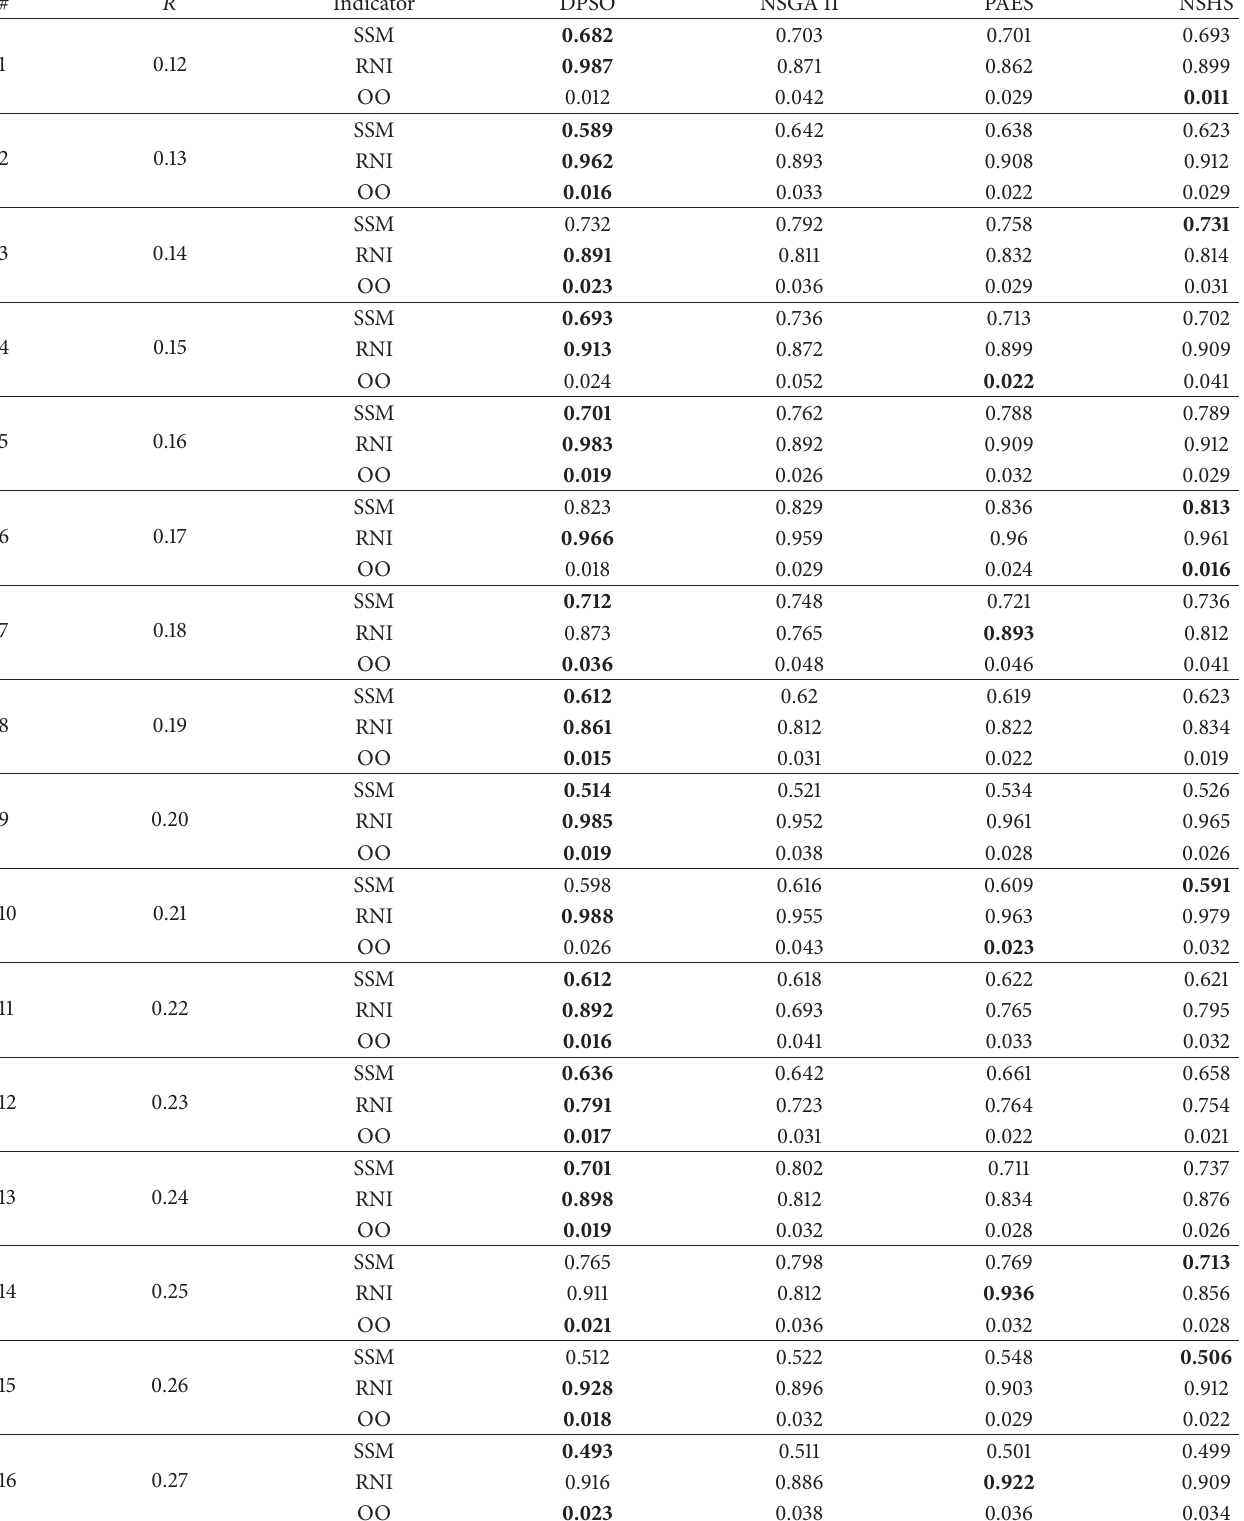
Table 8: The comparison between the multiobjective